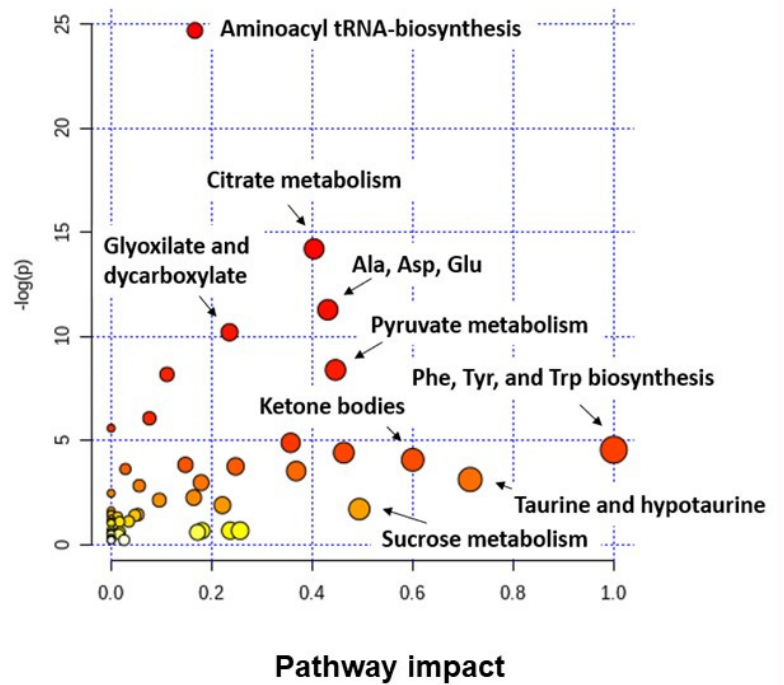
Figure 3. Analysis of altered metabolic pathways in BC when tumor and non-tumor samples (urine and serum) are compared. Note: the color and the size of each circle indicate its p -value and pathway impact value, respectively. Ala: alanine; Asp: aspartate; Glu: glutamine; Phe: phenylalanine; Tyr: tyrosine; Trp: tryptophan.